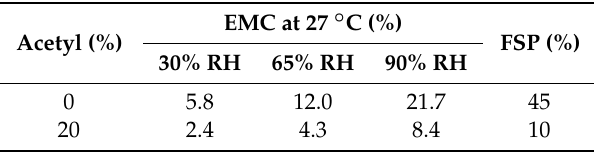
Table 2. Properties of acetylated pine [9].